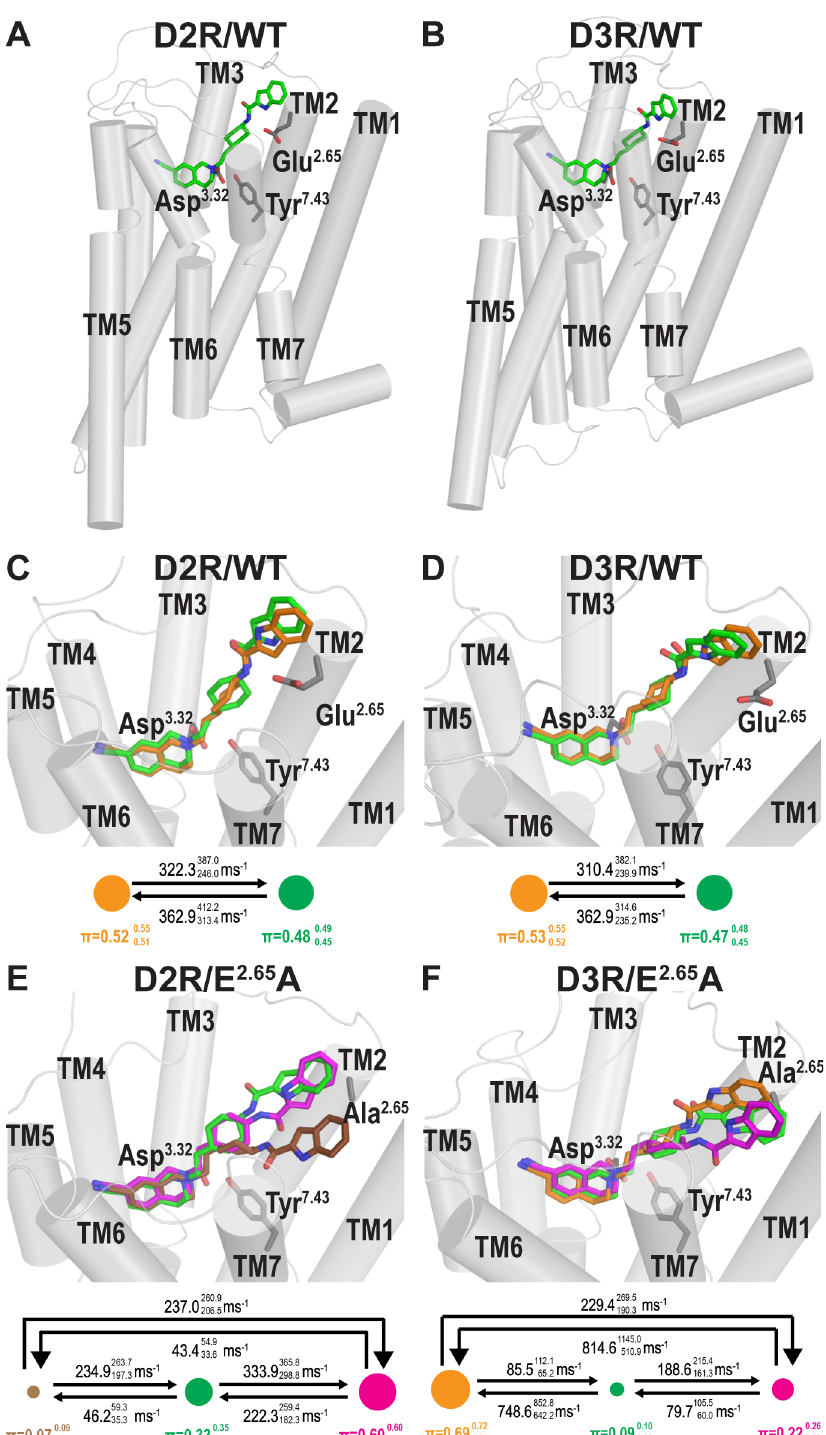
Fig 1. The SP of SB269652 is in dynamic equilibria of binding modes at D2R and D3R. Panels A and B show the binding modes of SB269652 at D2R/WT and D3R/WT that H-bond with Glu 2.65 . Panels C and D are zoom-in views of A and B respectively, with additional binding modes of the SP identified by MD simulations and MSM analysis. Our MSM analysis identified two MSs of SP binding (shown in green and orange). The area of each of the spheres representing a MS is proportional to its equilibrium probability (π); the transition rates between the MSs are shown above the arrows connecting them. Panels E and F show the binding modes of SB269652 at mutant D2R/E 2.65 A